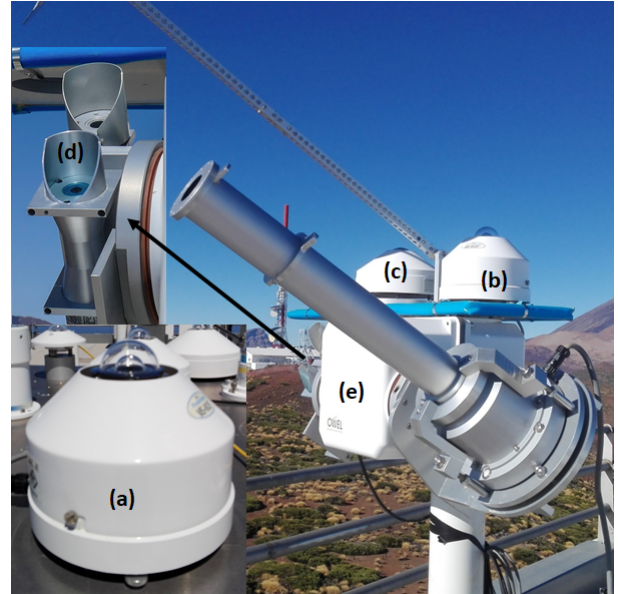
Figure 2. Basic-BSRN radiation instruments currently in operation at IZA BSRN. (a) SWD: EKO MS-802F pyranometer installed on a table (horizontal); (b) DIF: EKO MS-802F pyranometer; (c) LWD: Kipp & Zonen CGR4 pyrgeometer; (d) DIR: EKO MS-56 pyrhe- liometer; and (e) Sun tracker: Owel INTRA